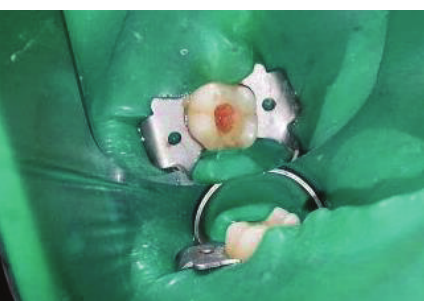
Figure 5: Placement of platelet rich fibrin over the radicular pulp.